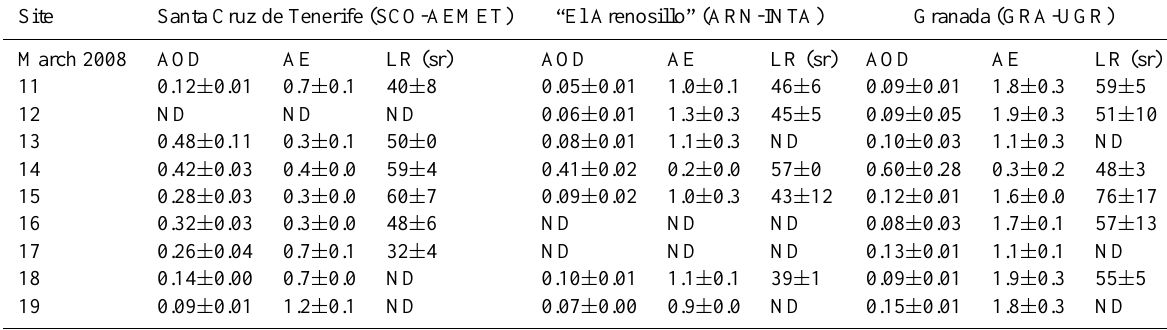
Table 2. AERONET daily mean AOD 500 , AE 440 / 675 and LR AERONET (see text for details) for the overall dust tracking monitored period (ND denotes no data available). Site Santa Cruz de Tenerife (SCO-AEMET) “El Arenosillo” (ARN-INTA) Granada (GRA-UGR)